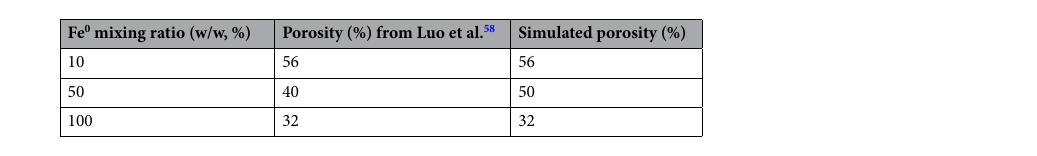
Table 3. Porosity values for different Fe 0 mixing